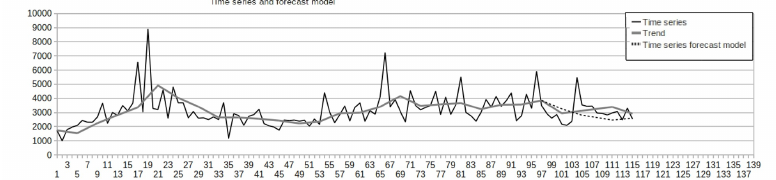
Figure 8. Trend forecast in the test